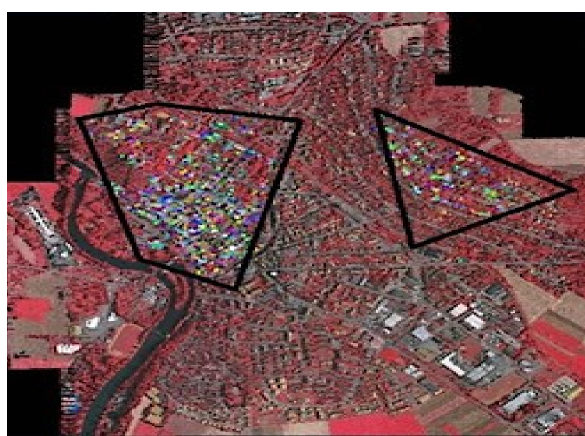
Figure 3. The parts of region forming training and testing sets.